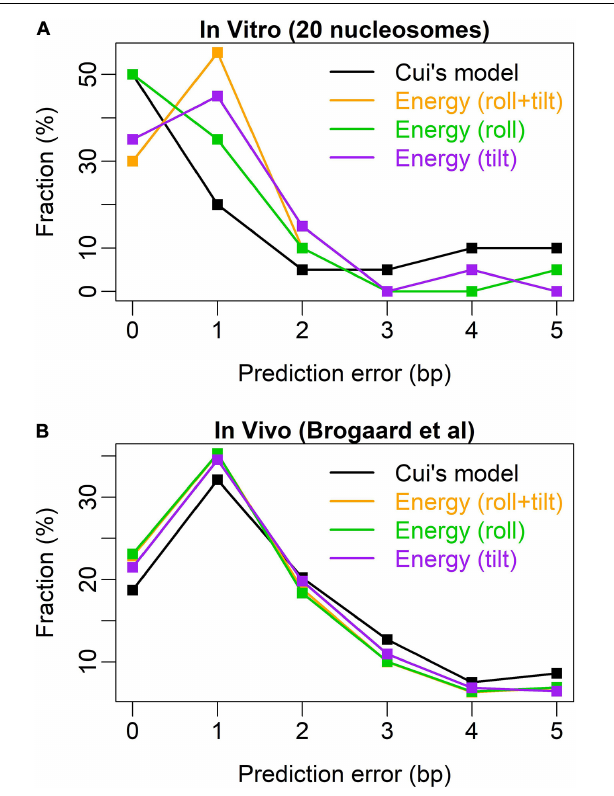
FIGURE 3 | Error distribution for the prediction models. (A) Test results of 20 nucleosomes assembled in vitro (Cui et al., 2014); (B) test results of the in vivo map with base-pair resolution (Brogaard et al., 2012). Similar to Cui et al. (2014), the abscissa denotes the prediction error measured by the distance between the experimental nucleosome position and the predicted position with the lowest deformation energy in the interval [-5, +5] around the real nucleosome position. The ordinate denotes the percentage of the error class in the total predicted nucleosome positions.